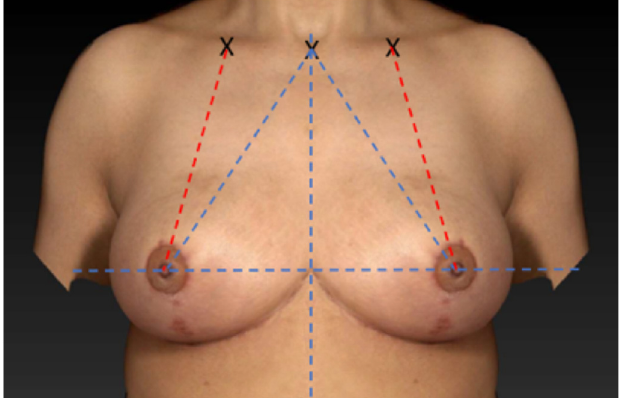
Figure 1. Symmetrical mirrored computer-simulated breast